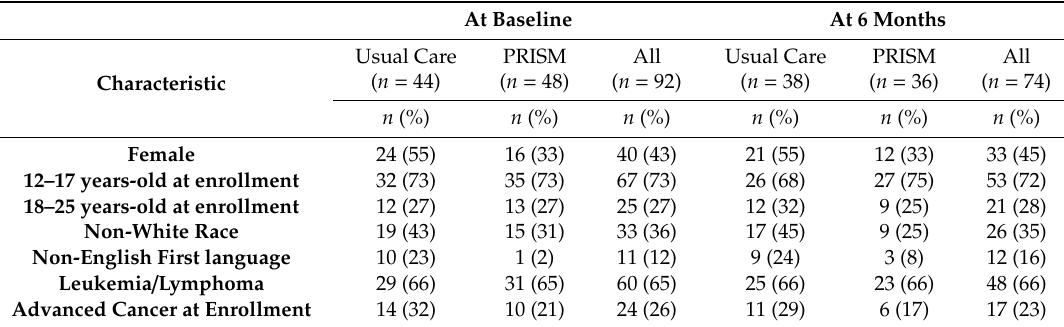
Table 1. Participant characteristics at time of enrollment, for patients who completed baseline and six-month